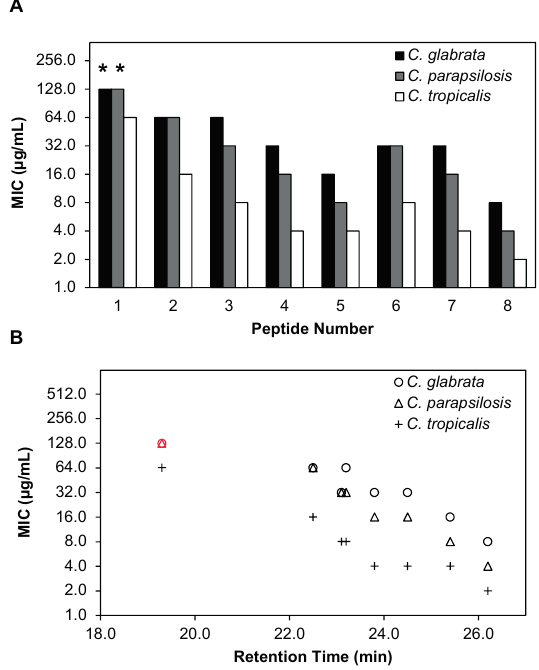
Figure 2. β -peptides are effective against planktonic C. glabrata , C. parapsilosis , and ( A ) Minimum inhibitory concentrations (MICs) of peptides 1 – 8 against C. glabrata (black bars), C. parapsilosis (grey bars), and C. tropicalis (white bars). MICs were determined by incubating C. glabrata , C. parapsilosis , and C. tropicalis cells (10 3 cells/mL) with β